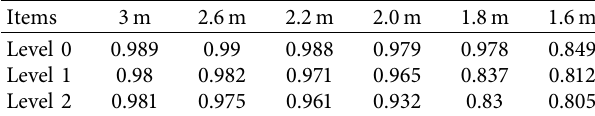
Table 8: Test results of arch bridge (tailwind,